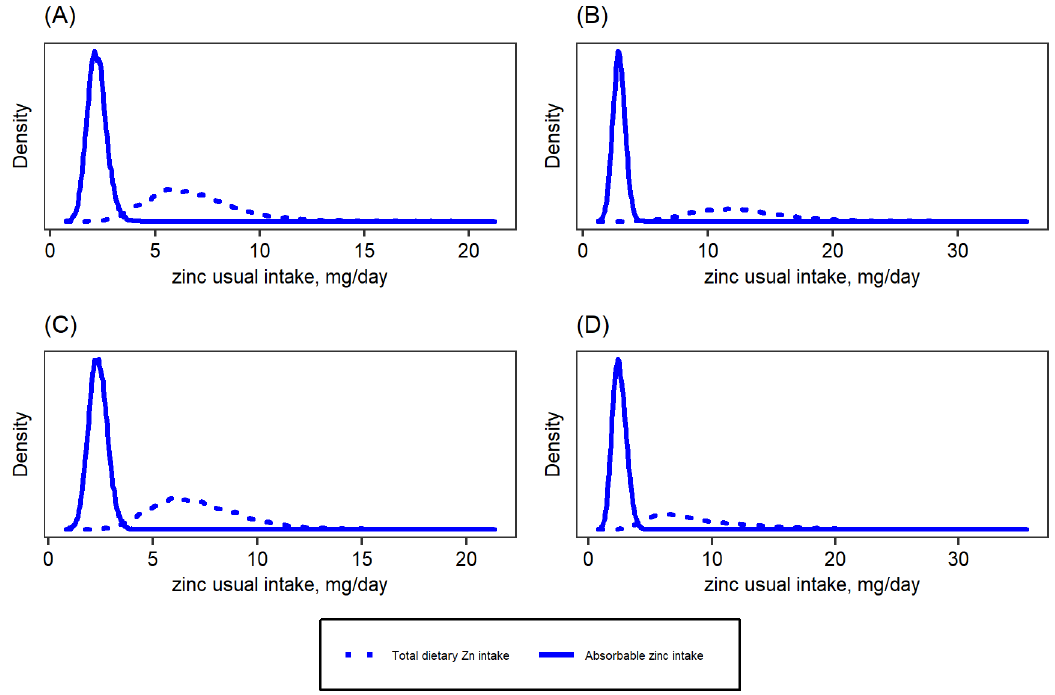
Figure 2. Total dietary and absorbable zinc intake distributions among women of reproductive age in Cameroon: ( A ) South macro-region, ( B ) North macro-region, ( C ) Yaound é /Douala, ( D ) National. Absorbable zinc intake was estimated based on Miller’s equation [23]. Table 2. Usual zinc and phytate intakes and phytate/zinc molar ratio among children 12– 59 months of age and women of reproductive age in Cameroon.